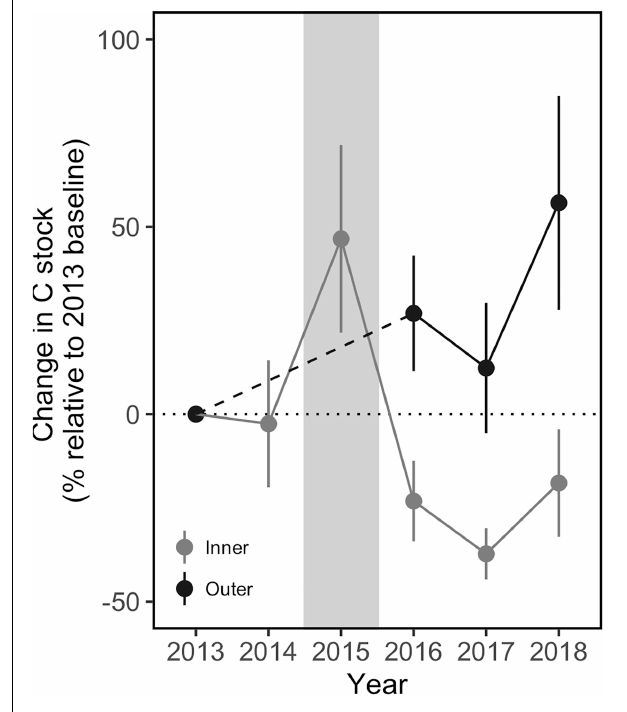
FIGURE 8 | Change in sediment carbon stocks in the surface sediments (0–5 cm) at the inner and outer meadow sites before and after the MHW, compared to a pre-disturbance 2013 baseline. Despite a pulse in sediment C observed within one month of the MHW, the inner sites lost sediment C and took 3 years to begin re-accumulating, with a net loss of 18% by 2018. In contrast, the outer sites showed a net increase of 56% in sediment C within 3 years after the MHW. Gray background indicates the year of the MHW. Values are mean ± 2 × SE, outer sites: n = 9 (2013), n = 4 (2016), and n =